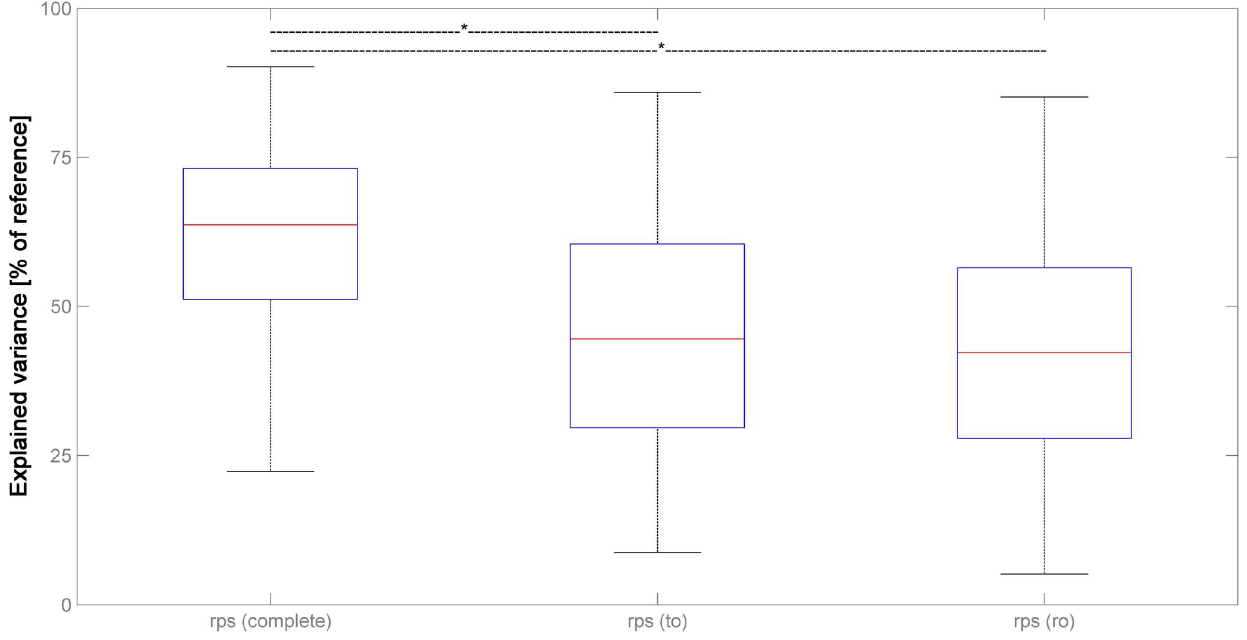
Figure 6. Illustration of the variance explained in dataset 3 (n=200) by different parameter combinations: complete set of realignment parameters [rps (complete)], realignment parameters from translation only [rps (to)] and rotation only [rps (ro)]. Note increasingly severe underestimation of total motion-induced variance when compared with the full parameter set including Volterra expansion (=100%); see text for details.